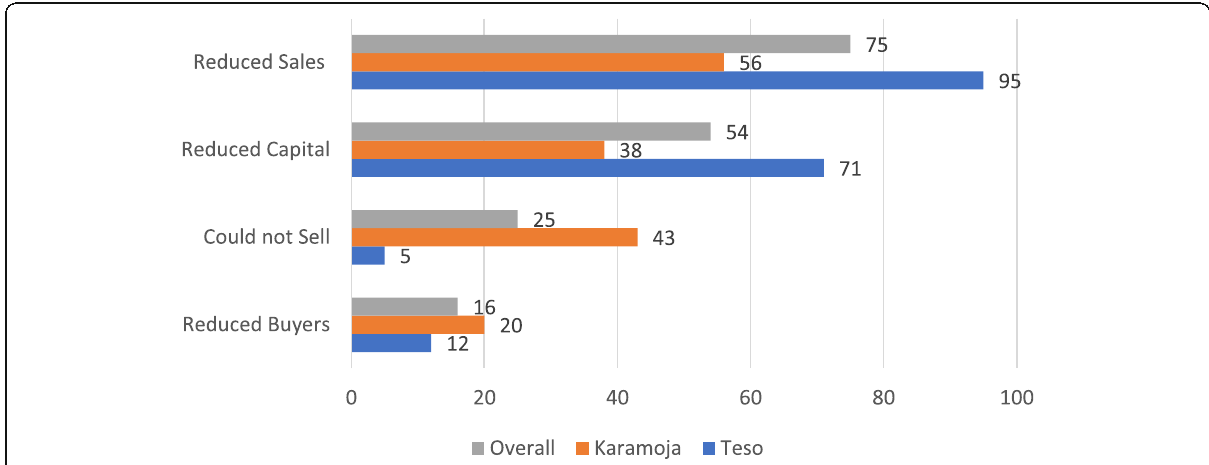
Fig. 4 Share (%) of cattle traders reporting ways in which COVID-19 affected cattle business in Teso and Karamoja